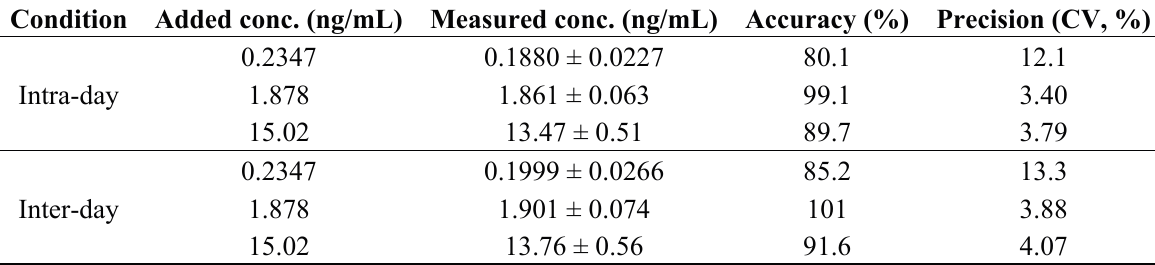
Table 1. Intra- and inter-day precision and accuracy of the ultra high performance liquid chromatography coupled with tandem mass spectrometry (UHPLC-MS/MS) method for determining sinomenine concentrations in human plasma (Mean ± SD, n = 5).